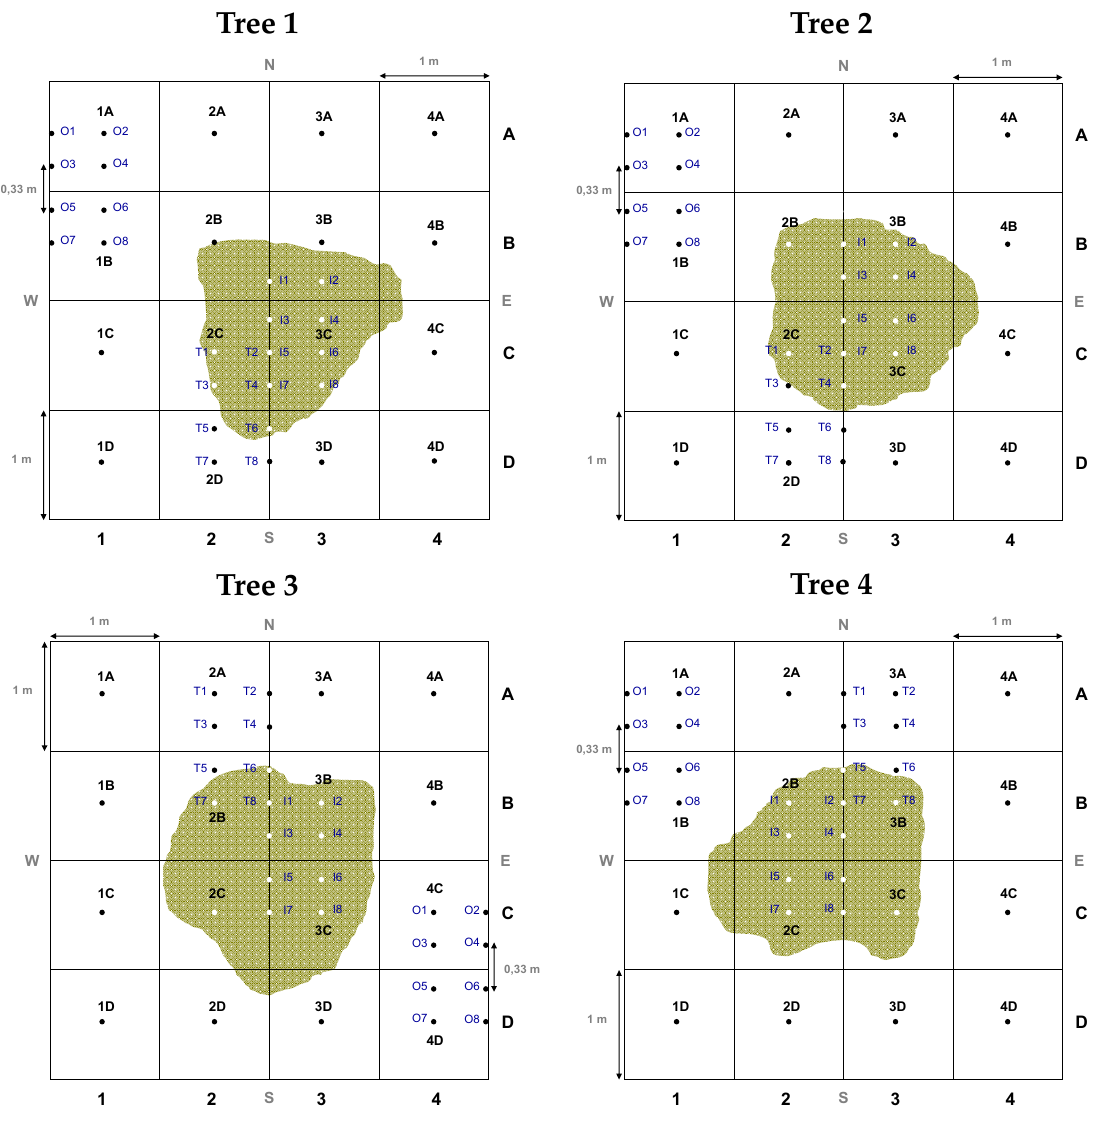
Figure 1. Soil sample design (according to Gallardo et al. [20] at two different scales: general grid (1 × 1 m) (G, n = 16) and specific position grid (0.5 × 0.33 m) corresponding to inside of the crown cover (I, n = 8), transition (T, n = 8), and outside of the crown cover (O, n = 8) for each of the four sampled trees. The black points belong to the group outside of the crown cover (OC, n = 22) and the white points belong to the group inside of the crown cover (IC, n = 11). The letters N, E, S and W, indicate the cardinal points.